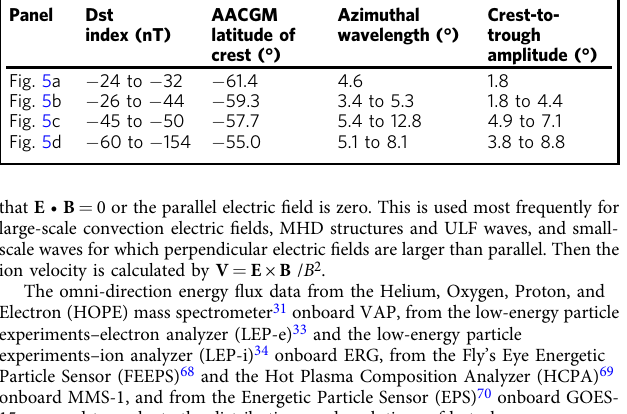
Table 1 Structural parameters of the SAs extracted from Fig. 5. Panel Fig. 5a − 24 to −